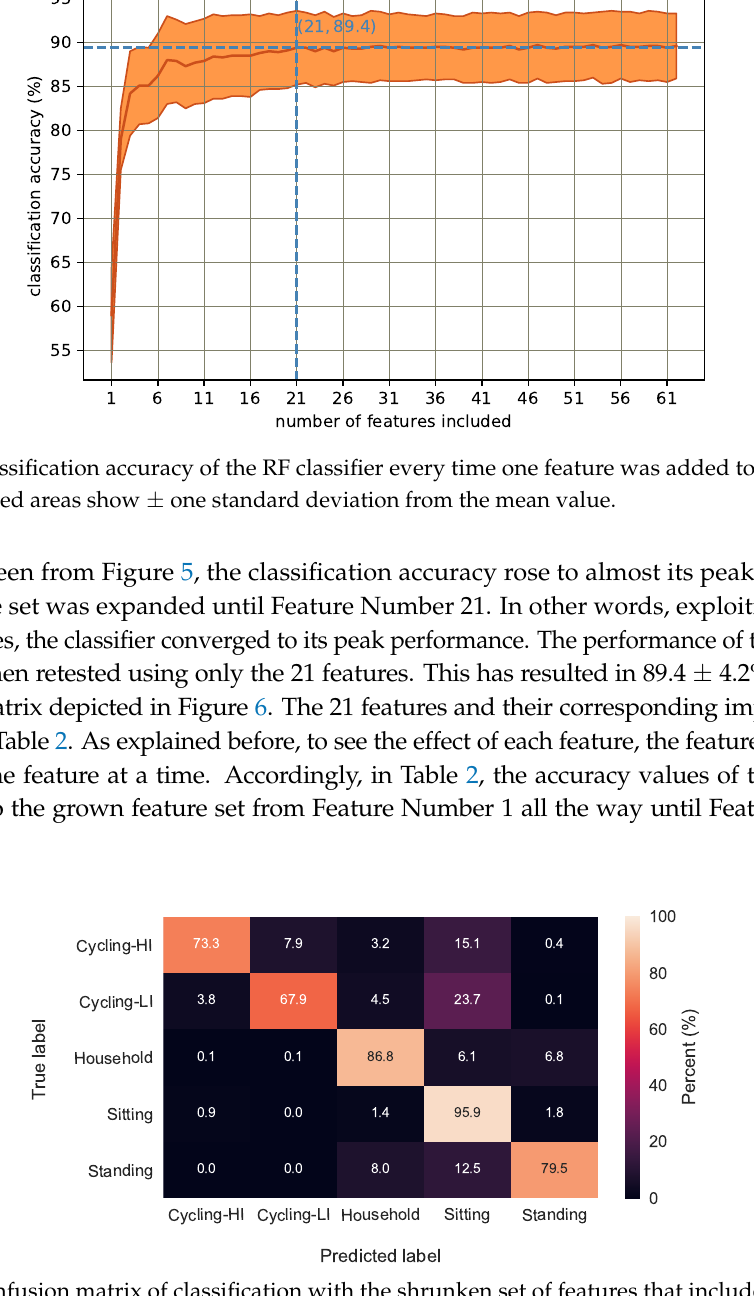
Figure 6. Confusion matrix of classification with the shrunken set of features that included both HR and ACC